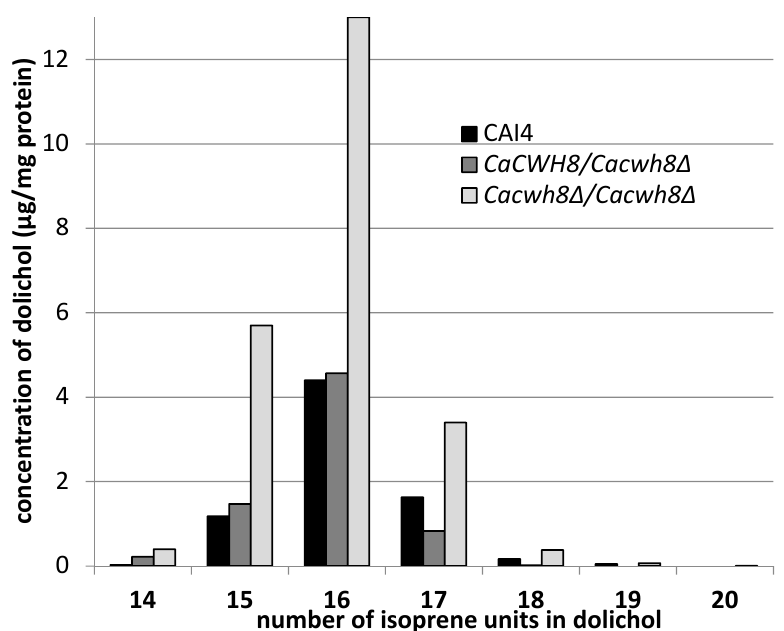
Figure 3. Content of dolichols of defined chain length in the wild type C. albicans strain CAI4 and the CaCWH8 mutants.